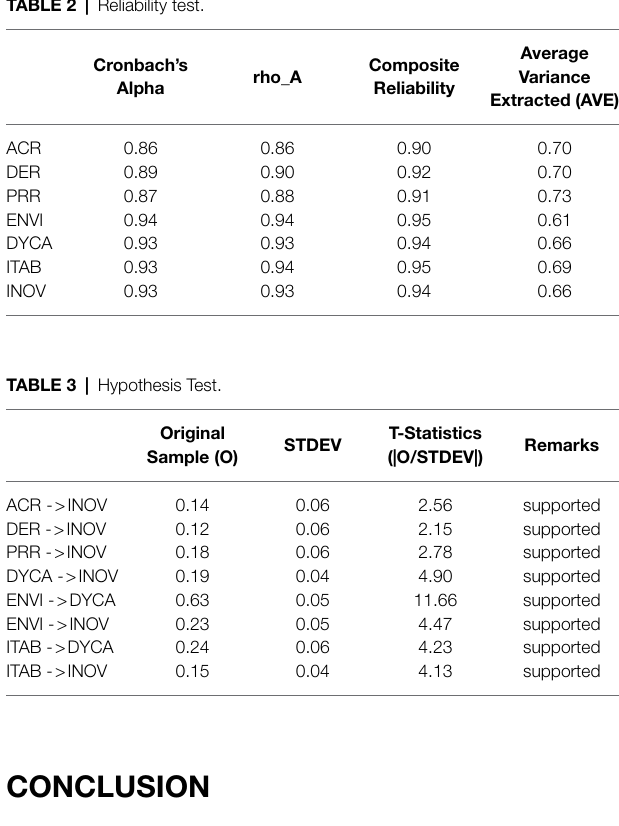
TABLE 2 | Reliability test.